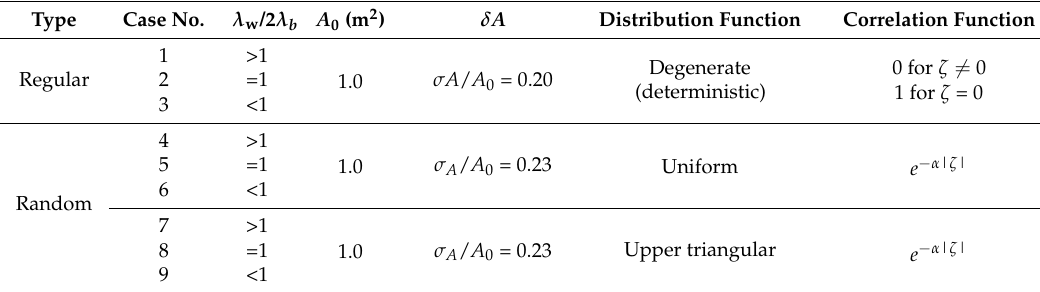
Table 1. Settings for the numerical test cases.